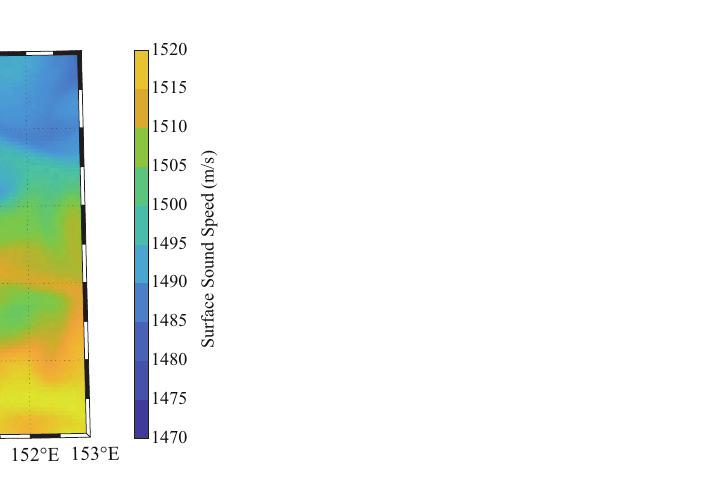
Figure 6. Sound speed of the ocean surface. Colour shading indicates sound speed fluctuation.